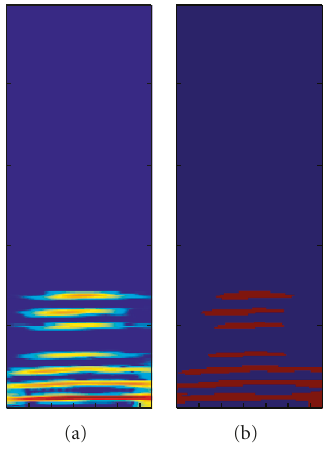
Figure 3: The reconstructed region of formants and the corre- sponding support